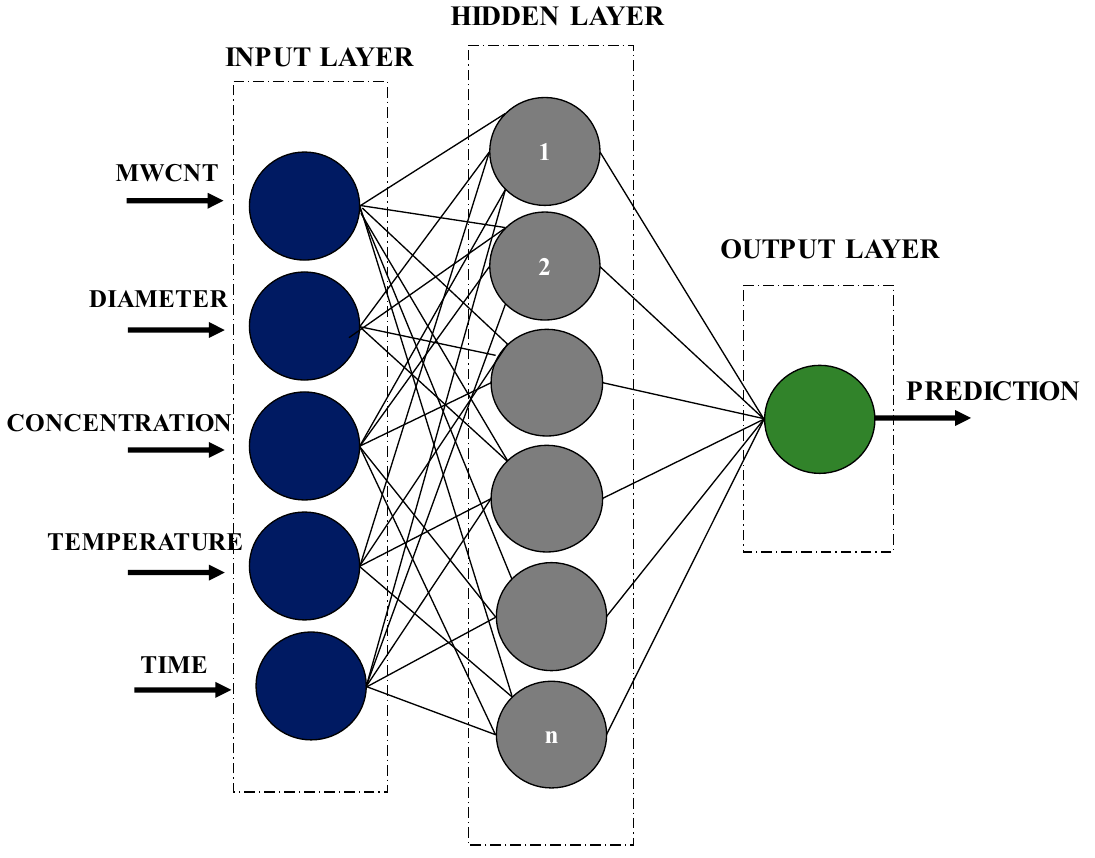
Figure 3. Proposed ANN architecture.